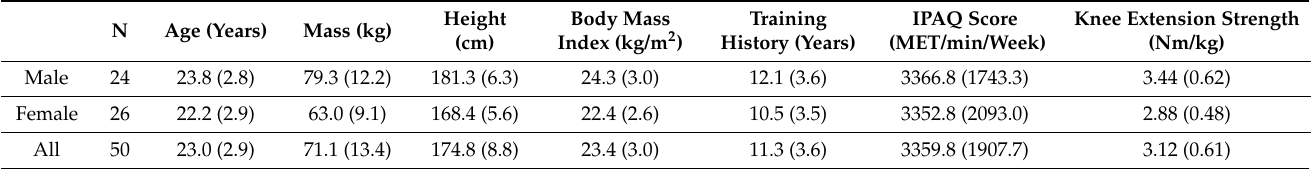
Table 1. Main characteristics of the